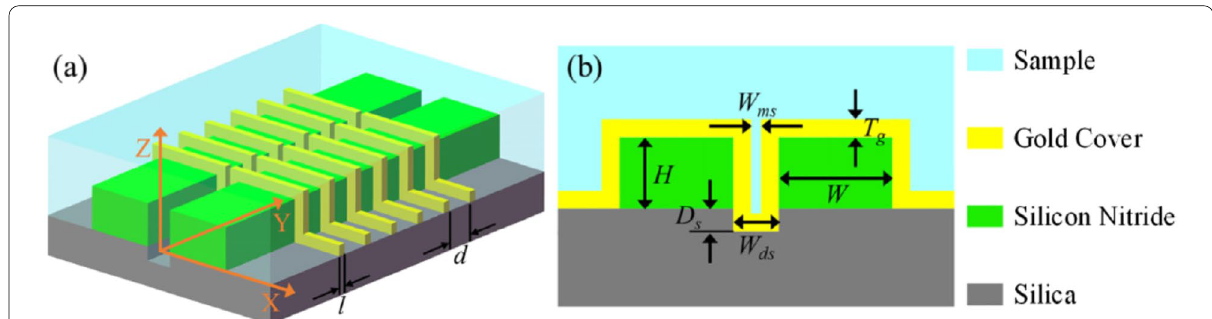
Fig. 7 a Schematic diagram of the SERS sensor based on the hybrid plasmonic grating slot waveguide. b Cross section of the hybrid plasmonic slot waveguide. (Reprinted with permission from Ref. [58])